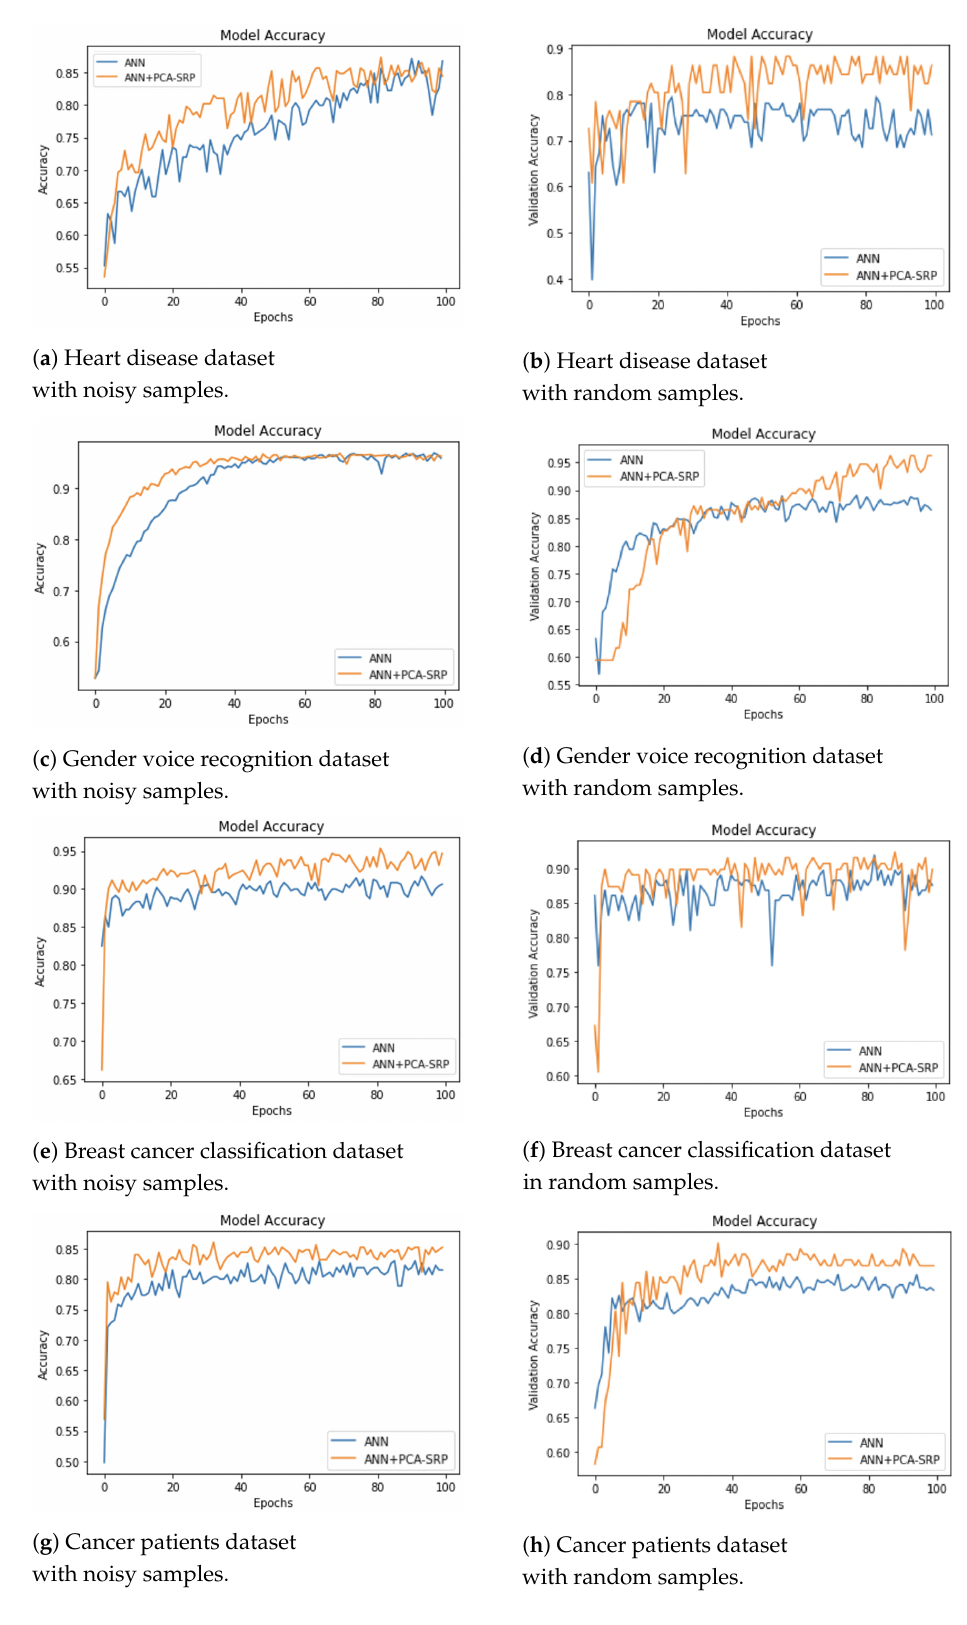
Figure 21. Validation model accuracy of the given datasets. The difference between dataset accuracy subjected to noise and random samples are the definition of the accuracy curve line between ANN + PCA–SRP to ANN